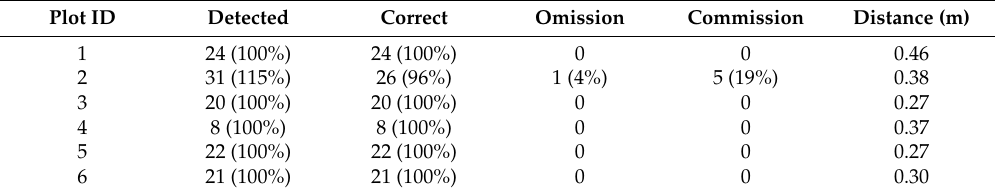
Table 2. Counts of detected trees and detection errors in research plots. Meaning of columns is as follows: Counts of detected trees in plot (Detected); counts of correctly detected trees within 1 m distance from the real positions (Correct); counts of trees that were not detected (Omission); counts of false detections (Commission); average distance of correctly detected trees to real positions